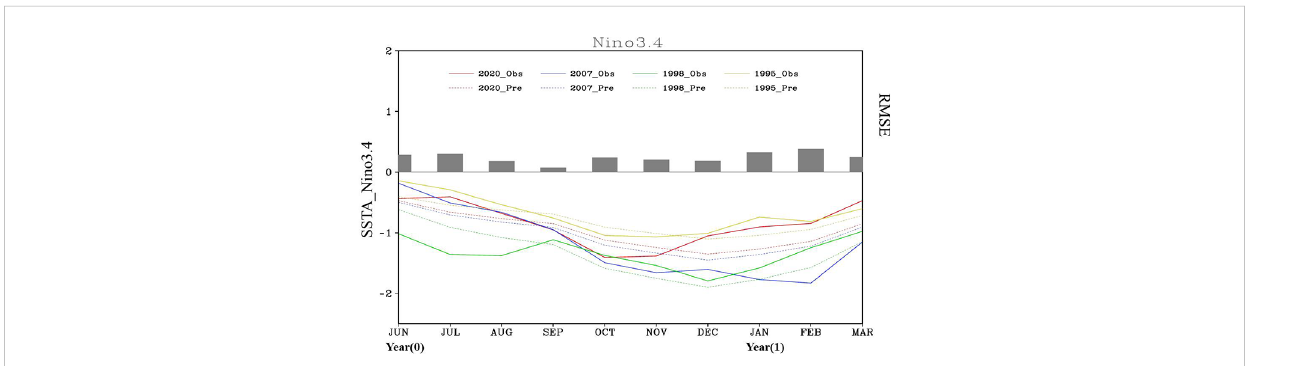
FIGURE 10 Forecasts of linear regression model at the evolution of the strong La Niña events. Niño3.4 index during 2020/2021, 2007/2008, 1998/1999, 1995/ 1996 La Niña events from the observation (solid lines) and prediction (dot lines) using the SLA in the SETIO in fall of 2019, 2006, 1997, 1994. Grey columns indicate the root mean square error